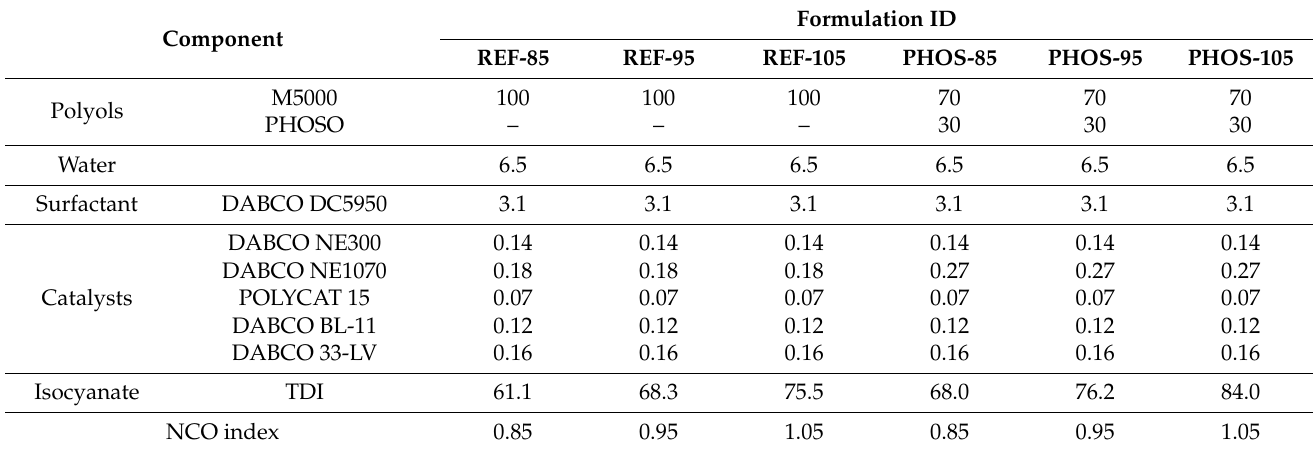
Table 1. Formulations used to prepare flexible polyurethane